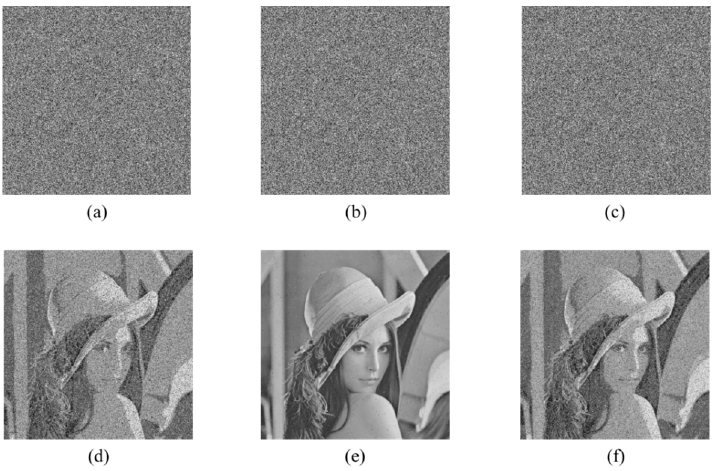
Figure 14. ( a – c ) Add 0.01 gaussian, salt and pepper, and speckle noise to the encrypted Lena. ( d – f ) are the decryption results of ( a – e ).